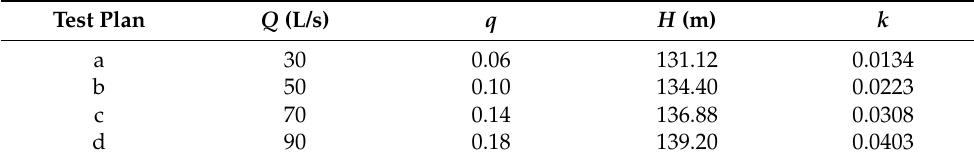
Table 3. Table of experimental conditions.